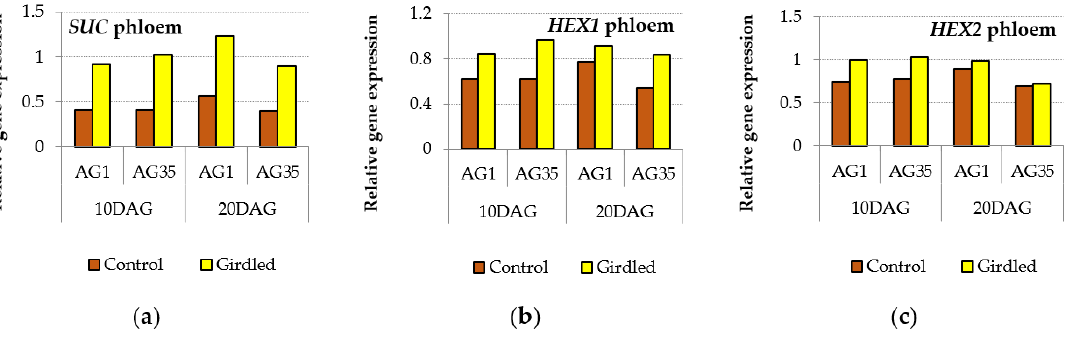
Figure 10. Relative gene expression of SUC ( a ), HEX1 ( b ), and HEX2 ( c ) genes in the phloem of control and girdled trees.